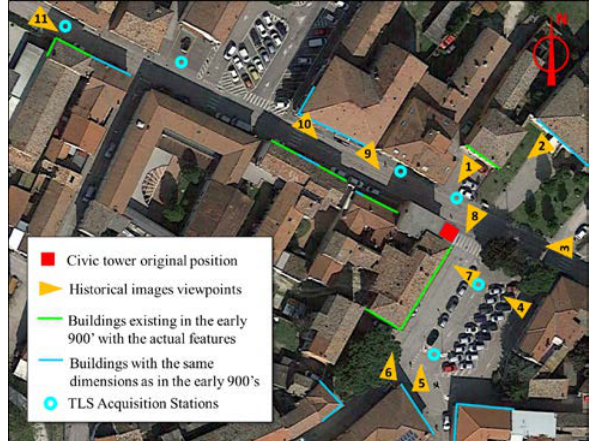
Figure 4. The main survey elements and the tower original